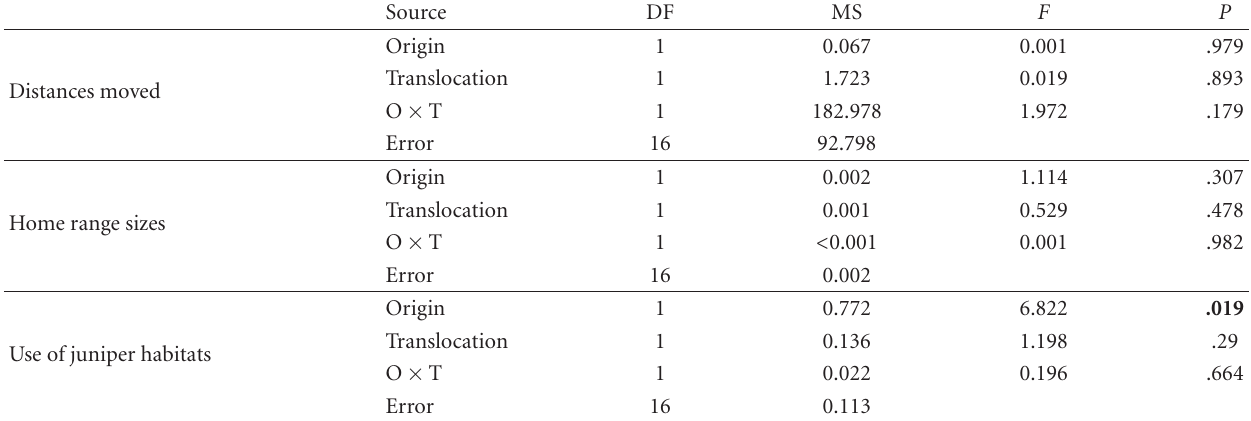
Table 4: ANOVA on the e ff ects of mink presence or absence on the island from which a vole originated (origin, O) and on the island where a vole was released (translocation, T) on the space and microhabitat use of voles. Source